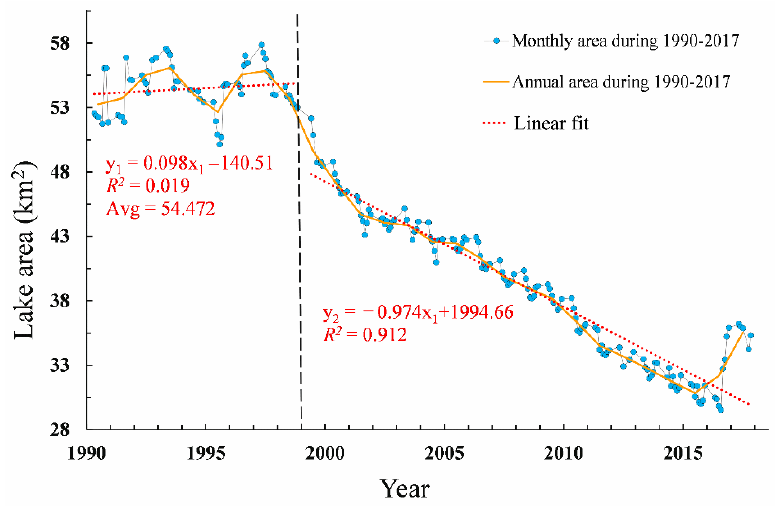
Figure 5. The changes in the shorelines of HN during 1990–2017.